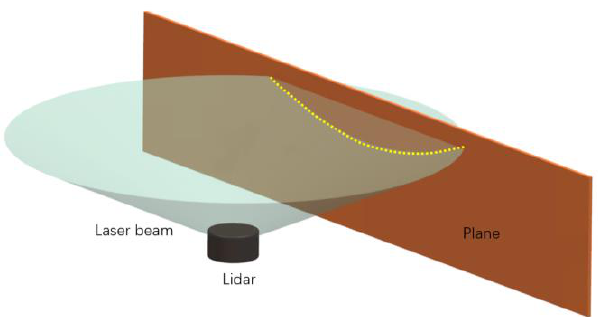
Figure 7. The measured curve on a vertical plane by a single laser beam.